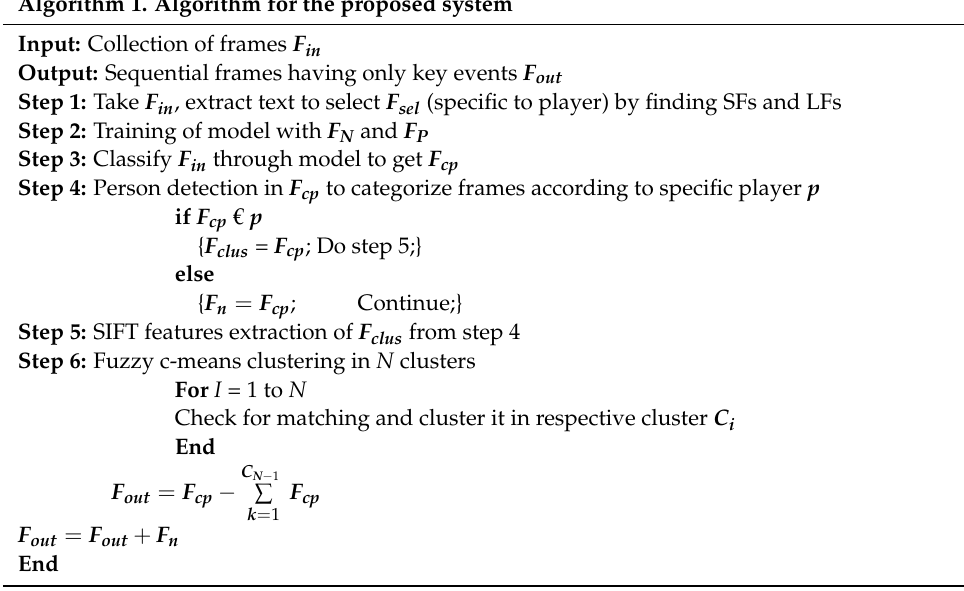
Algorithm 1. Algorithm for the proposed system